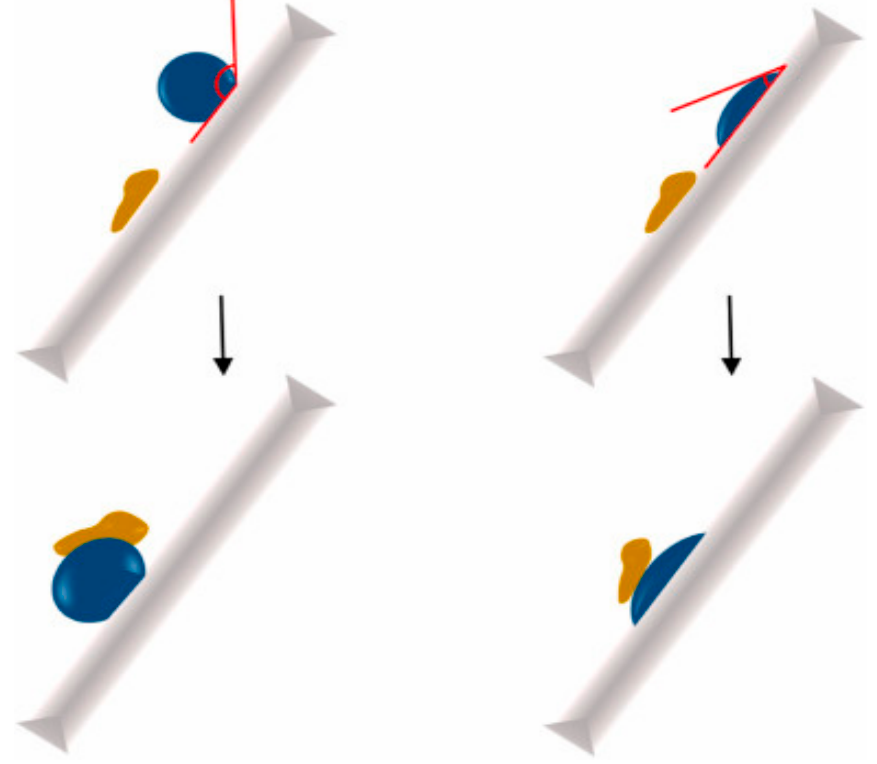
Figure 5. Coating mode of action: ( Left ) hydrophobic; ( Right ) hydrophilic, presented by [5].